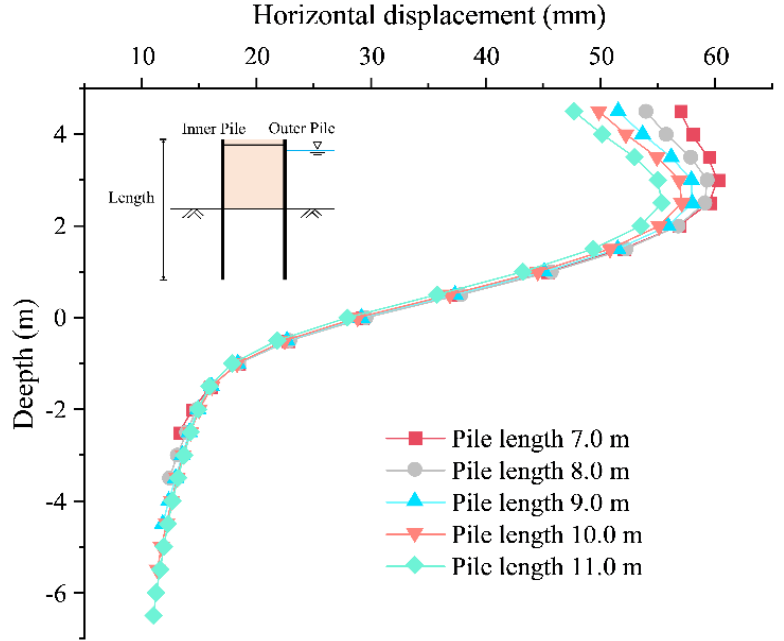
Figure 12. Pile horizontal displacement of different pile length conditions.